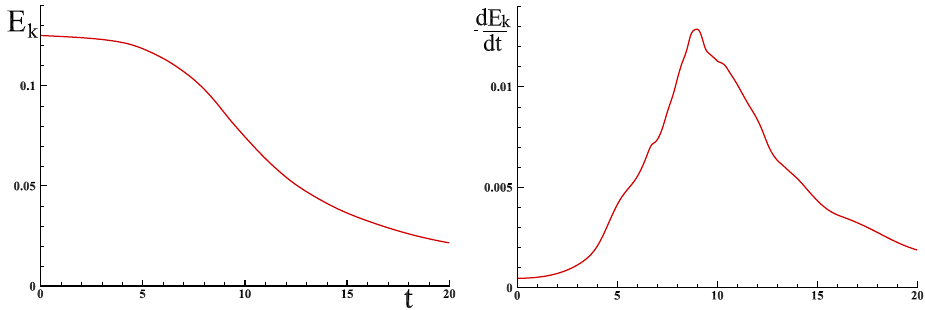
Figure 11. Taylor–Green vortex at Re = 1600; the spectral simulation provides the evolution of E k and dissipation rate ε = − dE k / dt for the Navier–Stokes model after W. van Rees [11], file Re-1600-